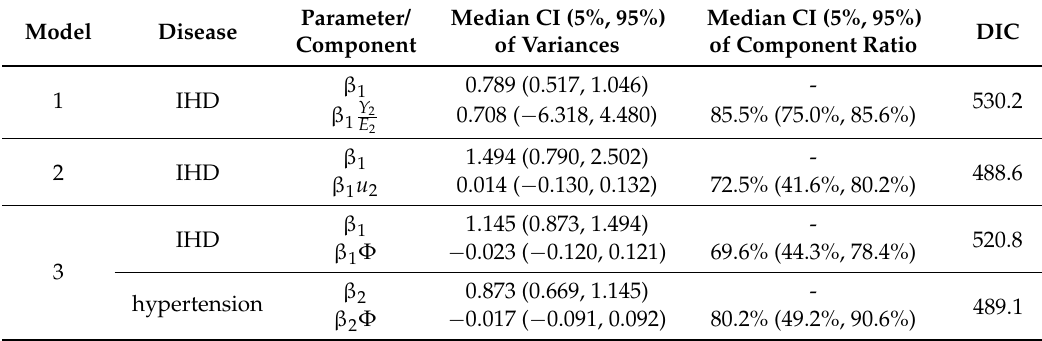
Figure 6. Results obtained using Model 3. Spatial patterns of posterior estimates of ( a ) overall IHD relative risk (RR); ( b ) overall hypertension RR; ( c ) shared component (with coefficients) of IHD; and ( d ) shared component of hypertension RRs. Table 1. Variances in log-form relative risks of IHD and hypertension; ratios of components in relative risks; and Deviance Information Criterion (DICs) of models.